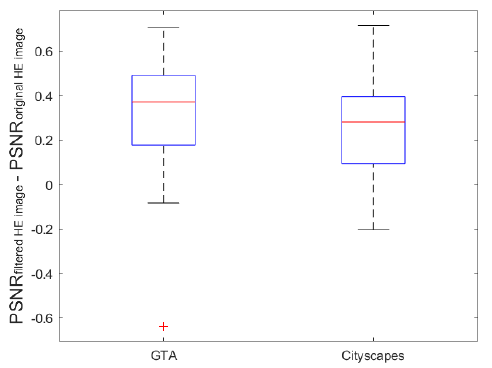
Figure 6. PSNR comparison between the filtered HE − enhanced image and the original HE − enhanced image.